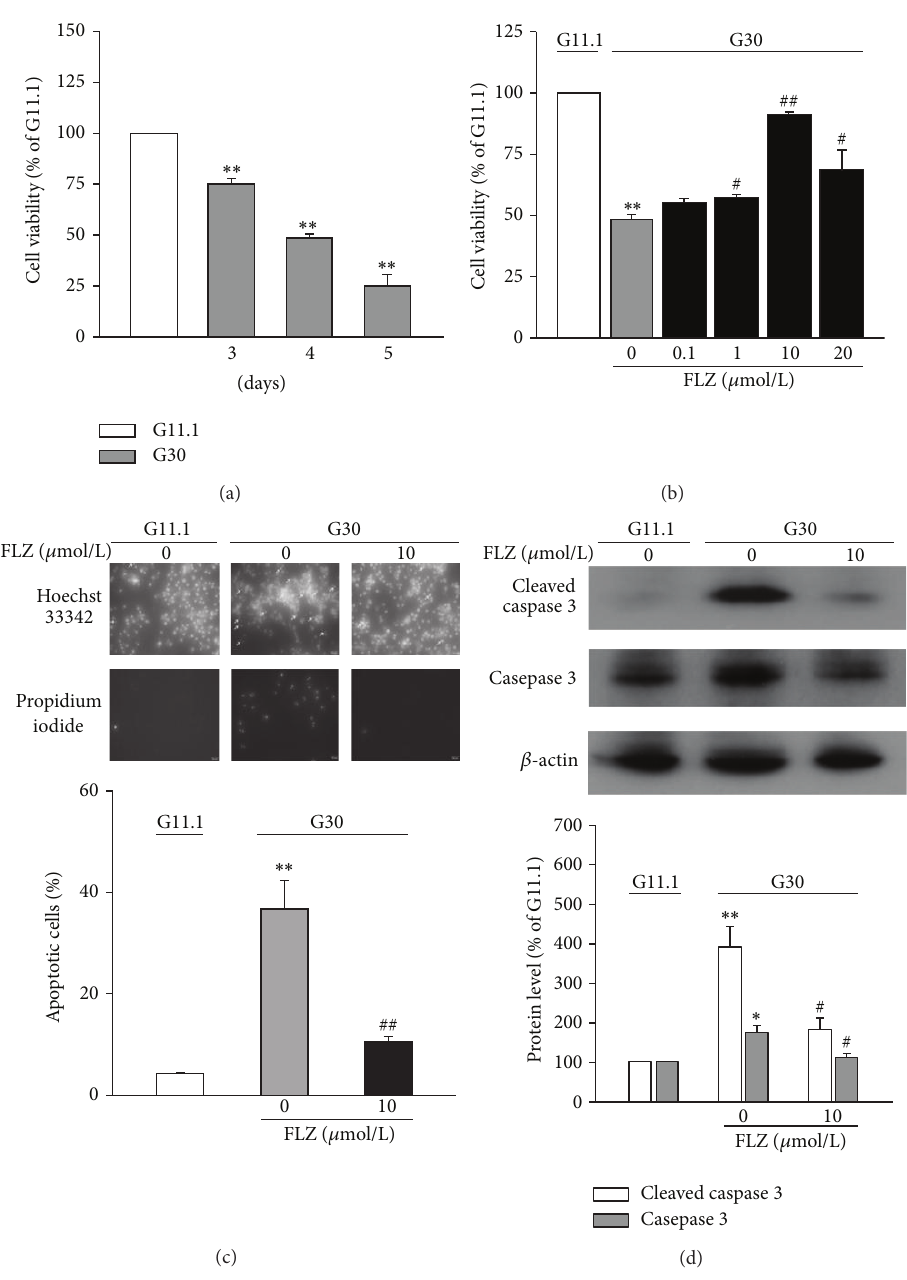
Figure 1: Treatment with FLZ prevents glucotoxicity in INS-1E cells. (a) INS-1E cells were cultured at G11.1 and G30 for 3–5 days and cell viability was assessed with MTT assay. Values were expressed as percentage of cell viability at G11.1. Data are means ± S.E.M. of 3–6 independent experiments. ∗∗ 𝑝 < 0.01 versus the value at G11.1. (b) Cell viability was assessed in INS-1E cells being cultured at G11.1 and G30 for 4 days. Cells were treated without or with varying levels of FLZ. Values were expressed as percentage of cell viability at G11.1. Data are means ± S.E.M. of 3 independent experiments. ∗∗ 𝑝 < 0.01 versus the value at G11.1; # 𝑝 < 0.05 , ## 𝑝 < 0.01 versus the value at G30 without FLZ. (c) Apoptosis assessed by HO/PI staining in INS-1E cells cultured at G11.1 and G30 for 4 days. Cells were treated without or with 10 𝜇 M FLZ. Arrows indicate HO-stained cells with apoptotic bodies (upper panel). Mean values ± S.E.M. of 3 independent experiments (low panel). ∗∗ 𝑝 < 0.01 versus the value at G11.1; ## 𝑝 < 0.01 versus the value at G30 without FLZ. (d) INS-1E cells were cultured at G11.1 or G30 for 4 days. Cells were treated without or with 10 𝜇 M FLZ. Expression of total and cleaved caspase 3 protein was determined by western blot. 𝛽 -actin was used as an internal control (upper panel). Intensities of total and cleaved caspase 3 protein expression were quantified, normalized against the level of 𝛽 -actin, and expressed as fold of protein abundance in INS-1E cells at G11.1 (low panel). Data are means ± S.E.M. of 3 separate experiments. ∗ 𝑝 < 0.05 , ∗∗ 𝑝 < 0.01 versus the value at G11.1; # 𝑝 < 0.05 versus the value at G30 without